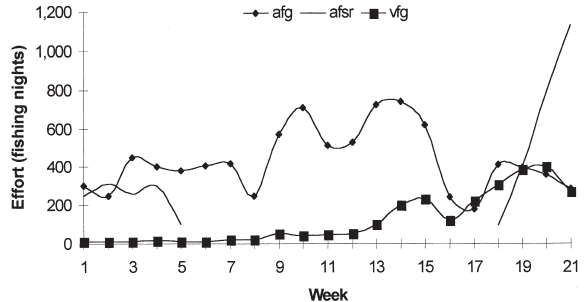
F IG . 3. – Variation in fishing effort observed, vfg = vessel fleet in Guaymas, afg = artisanal fleet in Guaymas, afsr = artisanal fleet in Santa